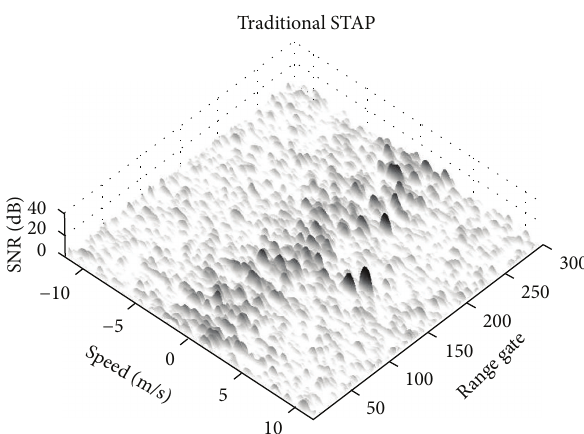
Figure 10: Range-Doppler map on RAMSES data showing the performance of classical STAP processing.